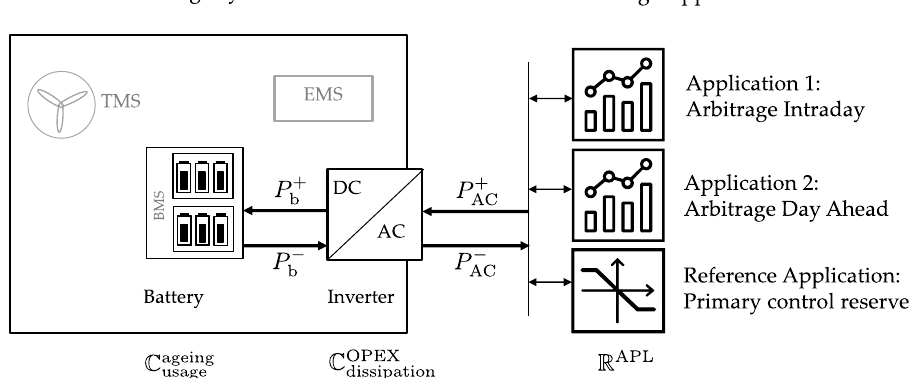
Figure 1. Schematic drawing of a battery energy storage system (BESS), power system coupling, and grid interface